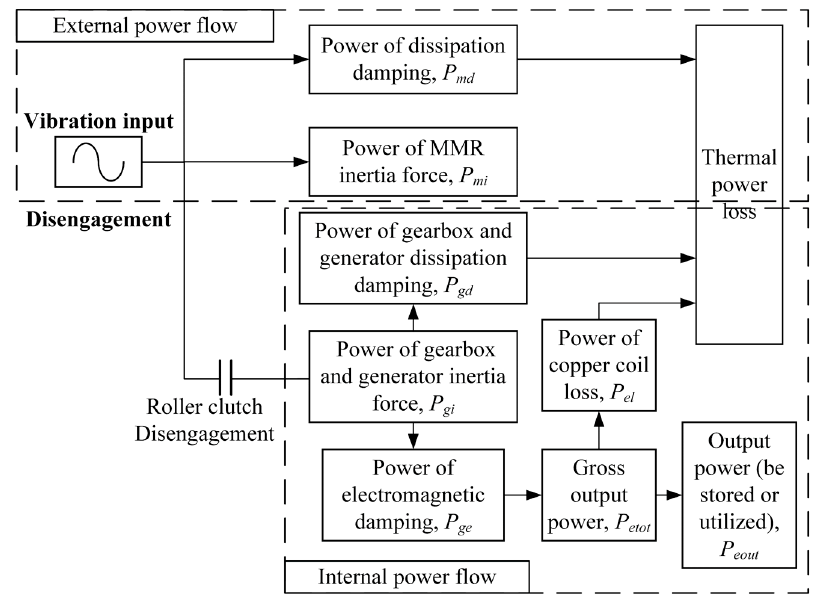
Figure 6. The power flow of the disengagement behavior.